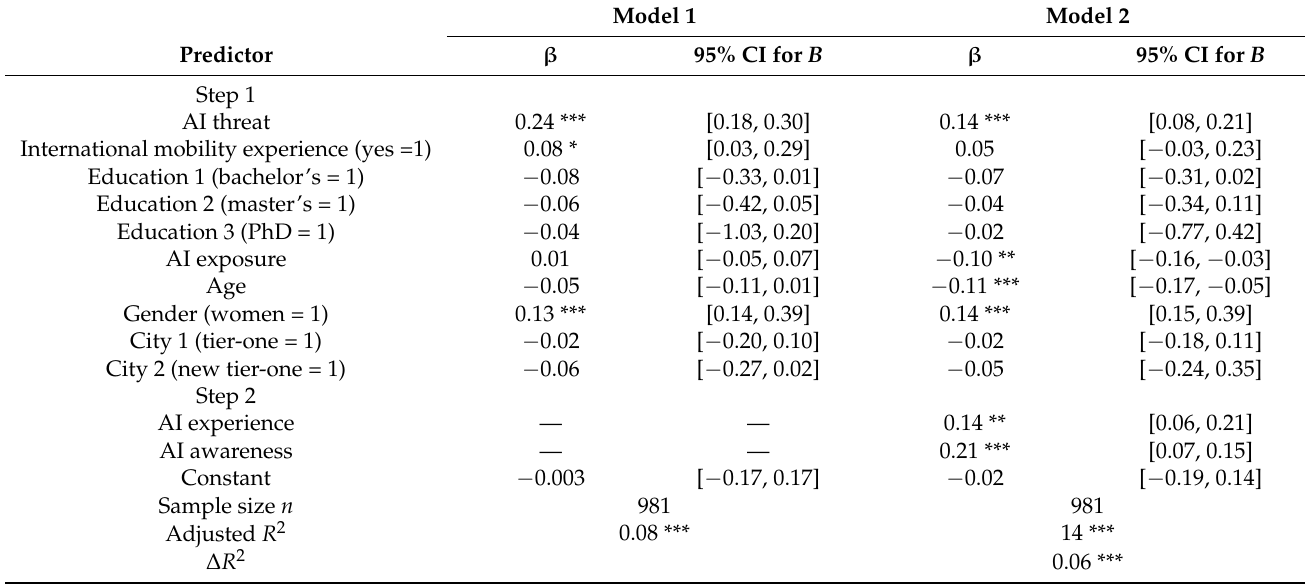
Table 6. Stepwise regression analysis of human identity, Study